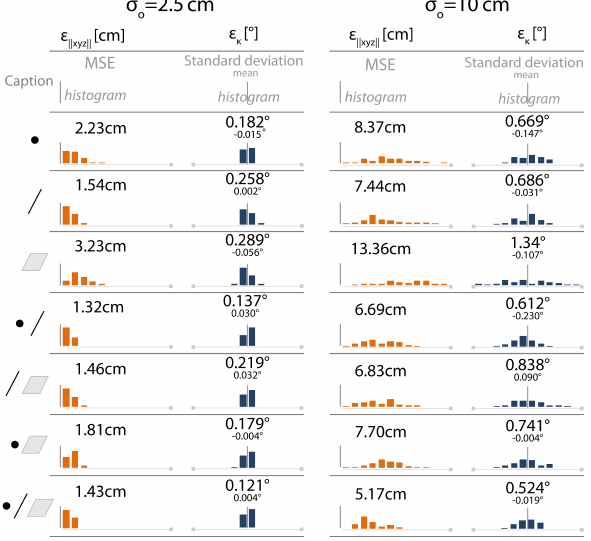
Figure 5: Errors in registration using 3D entities in the case of a corridor. 50 sample tests per case. Orange: error in position. Blue: error in orientation.